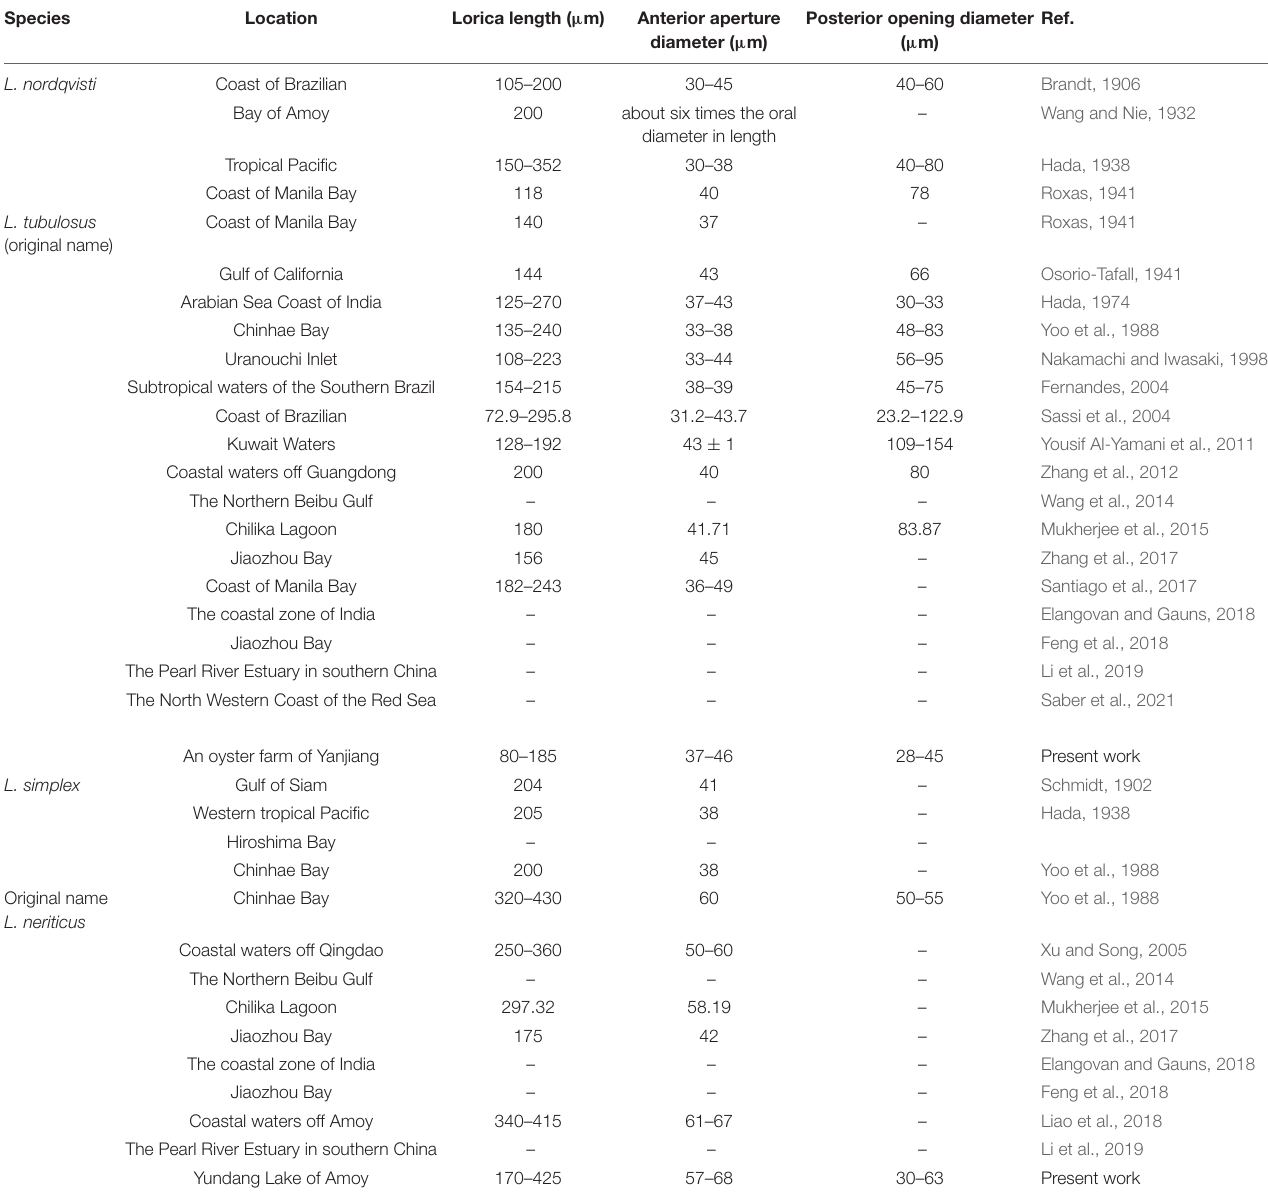
TABLE 3 | Morphology and distribution of reported populations of Leprotintinnus nordqvisti and L. simplex .